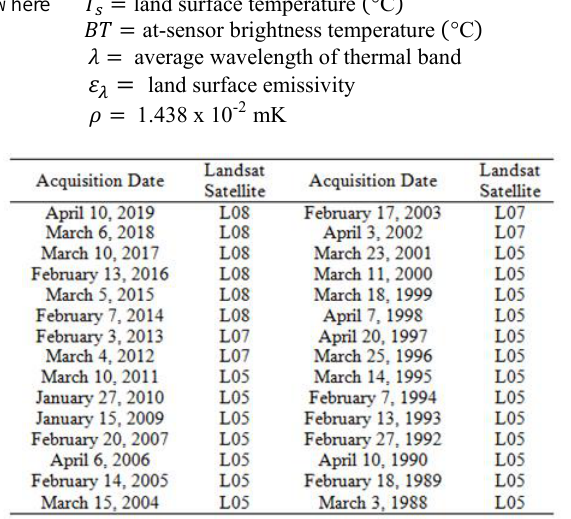
Table 4. Selected Image Acquisition Date per